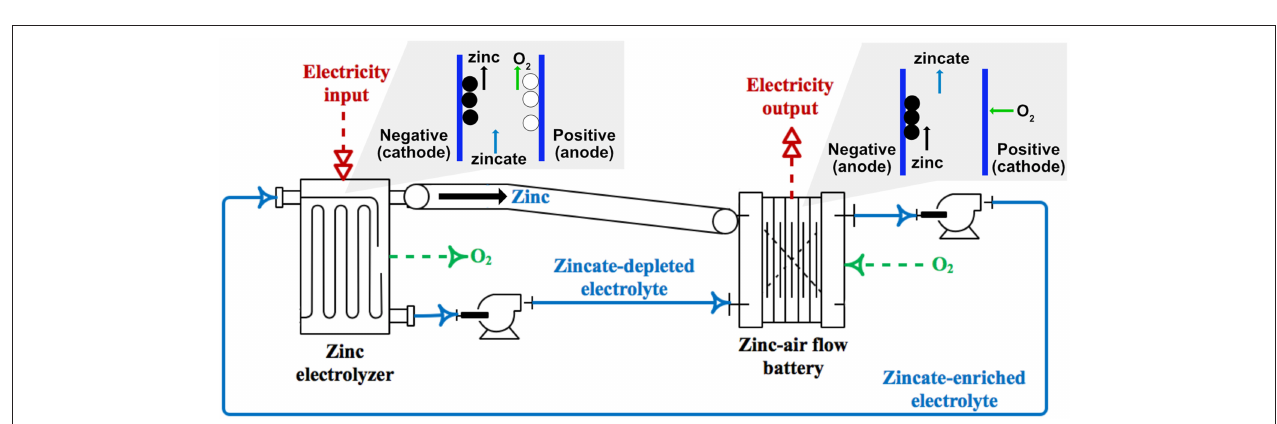
FIGURE 2 | Schematic diagram of zinc-air flow battery integrated with zinc electrolyzer.